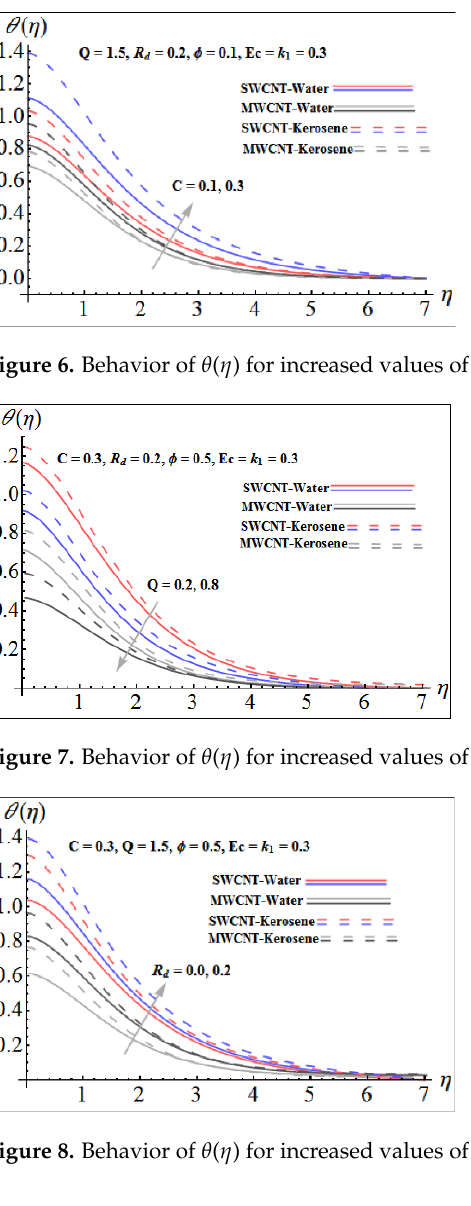
Figure 8. Behavior of θ ( η ) for increased values of 𝑅 (cid:3031) .